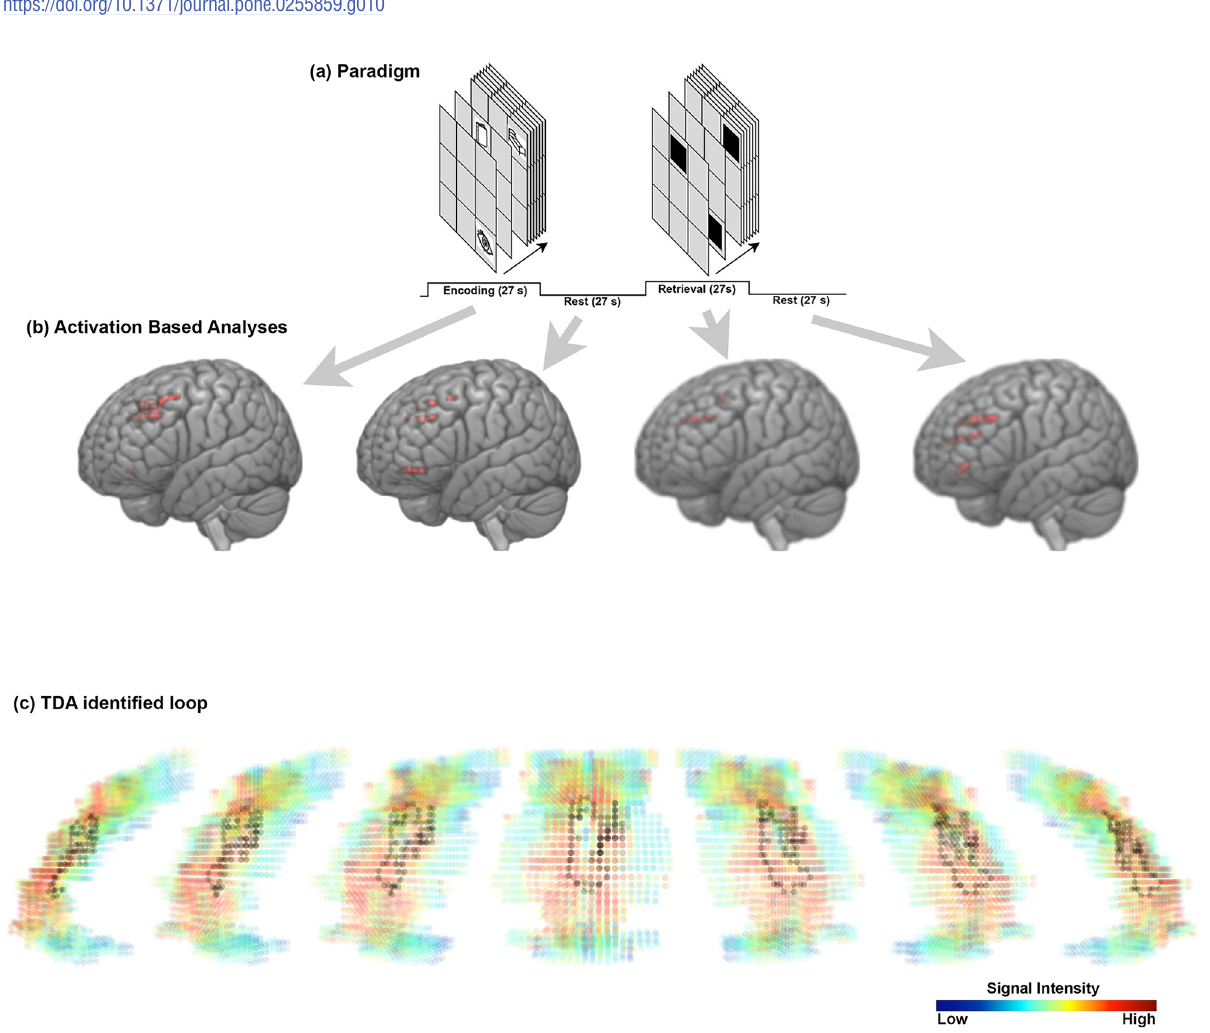
Fig 11. The figure depicts (a) the learning paradigm used to evoke fMRI responses with each of the four conditions clearly depicted, (b) a rendering of the results of activation-based analyses on the anterior cingulate cortex using regressors to represent each of the four conditions (p < .01, corrected), and (c) results of TDA analyses using our documented workflow. The workflow and the statistical test (see text), shows that a non-contractible loop (pictured at time index t = 1) shows significantly more persistence during encoding than during retrieval. Note that the TDA- identified effects in (c) complement the activation-based analyses in (b) in their location in the